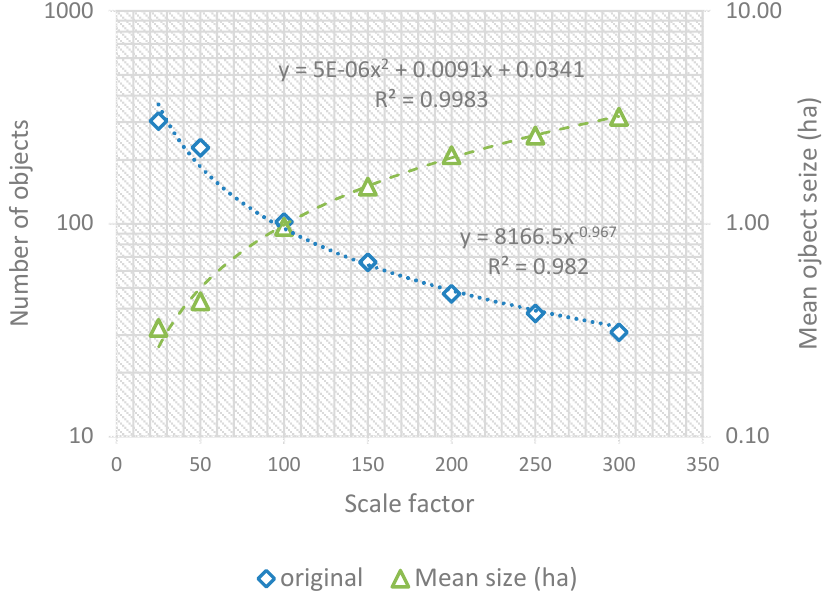
Figure 2. A power-based relation between segmentation scale factor and number of produced objects (or zones); and a quadratic relation between scale factor and mean object size, extracted from the multi-seasonal RapidEye image.